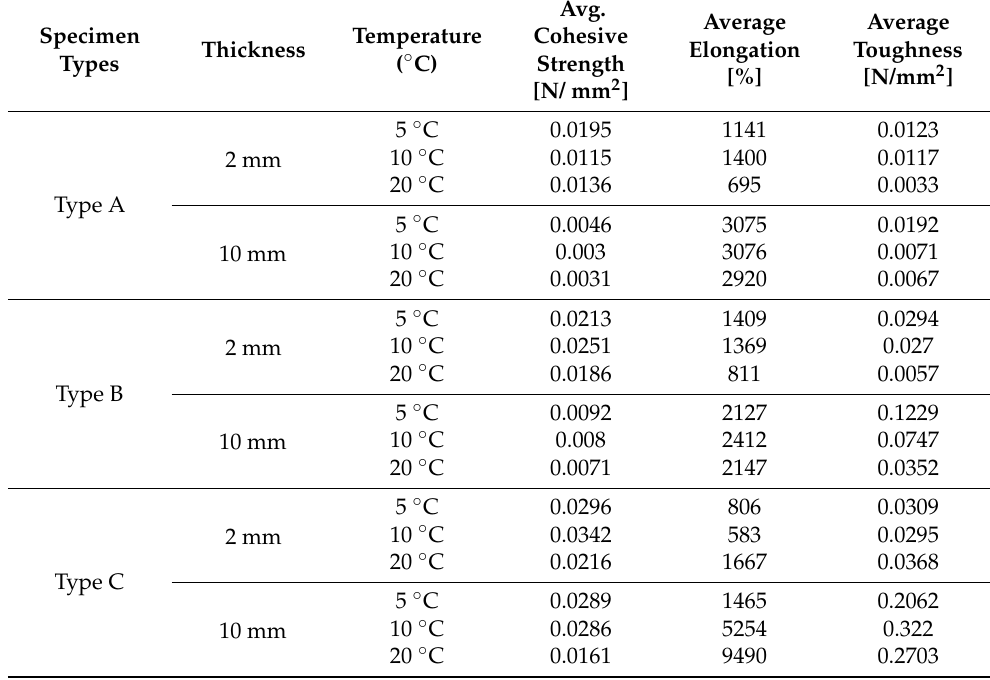
Table 5. Comprehensive measurement results for each sample.